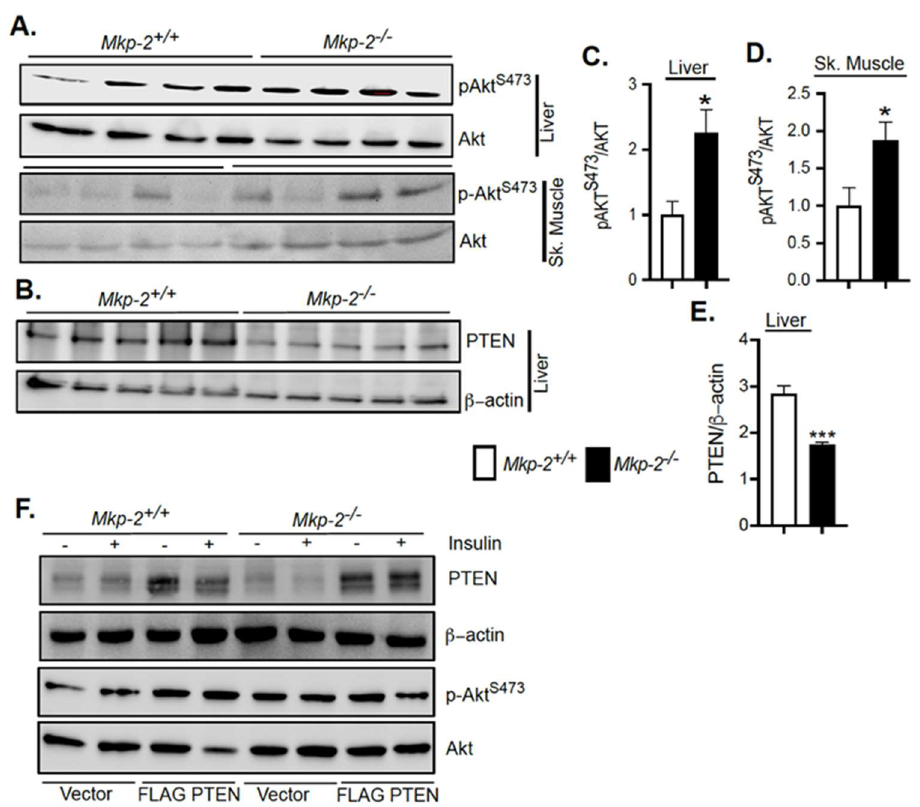
Figure 7. Enhanced Akt signaling in MKP-2 Deficient Mice. Liver and skeletal muscle lysates from overnight fasted insulin stimulated (i.p.) HFD-fed (5 weeks) Mkp-2 +/+ and Mkp-2 −/− mice were analyzed by immunoblotting (N = 4–6 mice/genotype). Representative immunoblots were quantitated by densitometry for phospho-Akt/Akt, liver ( A , C ), and skeletal muscle ( A , D ) and PTEN and β-actin ( B , E ). ( F ) Serum-starved MEFs were transfected with vector or FLAG PTEN followed by insulin (100 nM) stimulation for 1 h. Results represent the mean ± SEM; *; p < 0.05, ***; p < 0.0001, as determined by Student’s t -test. Open bars, Mkp-2 +/+ mice; closed bars, Mkp-2 −/− mice.